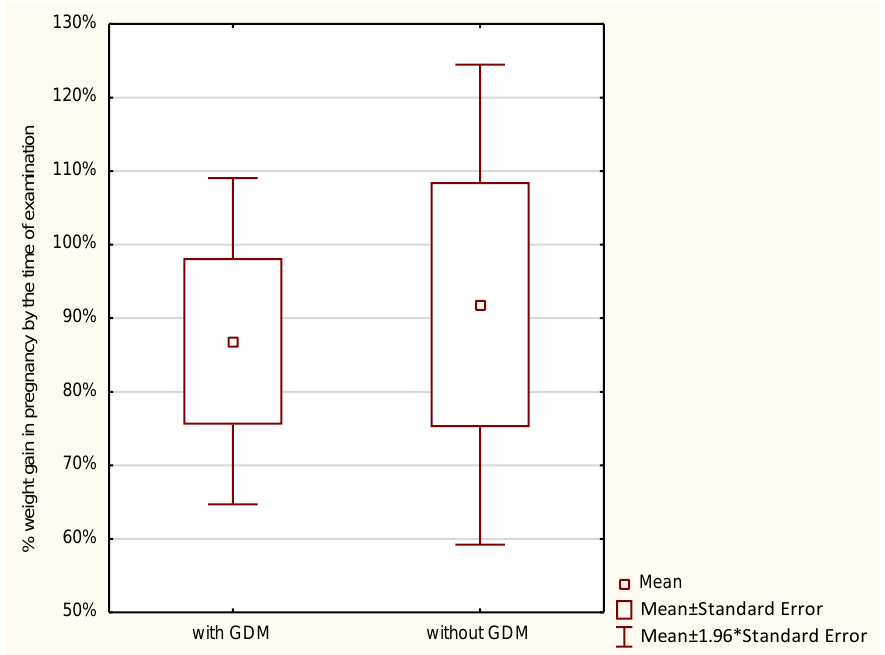
Figure 3. The percentage of GWG by the time of examination performed in pregnant women with a BMI < 18.5.